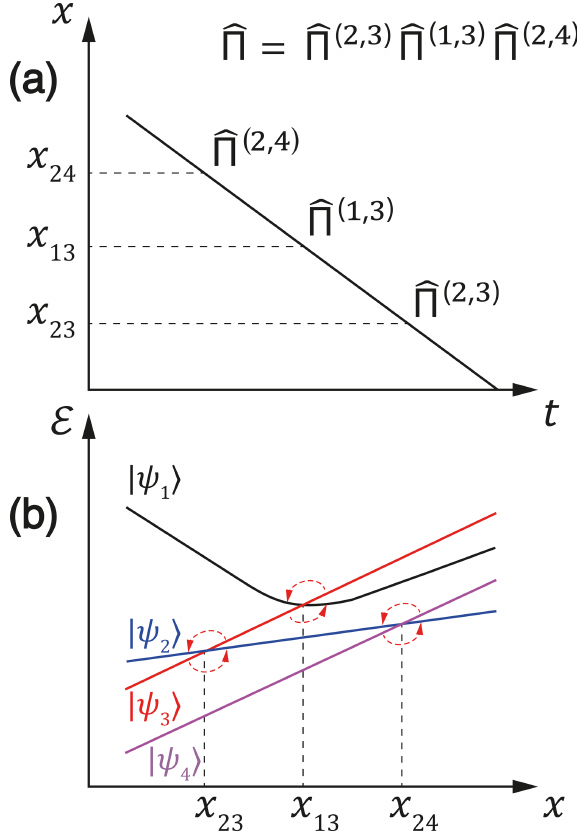
Figure 3. (a) Variation in the control parameter x with time. When the x value reaches the LAC region, mixing of the populations oc- curs; LC positions x kl are indicated as well as the permutation oper- ators. (b) Representation of the population mixing between the pairs of diabatic states at the corresponding LACs, indicated by arrows.